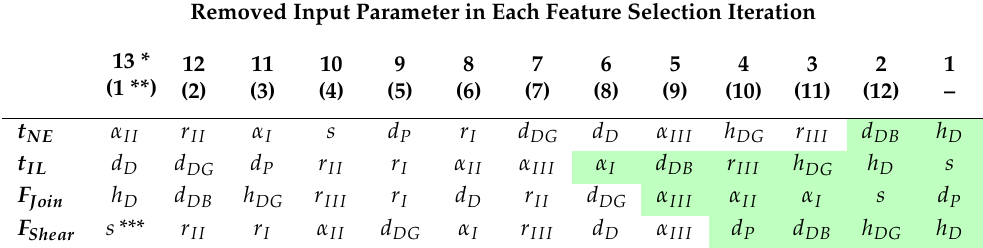
Table 2. Overview of the selected and removed input parameters in each feature selection